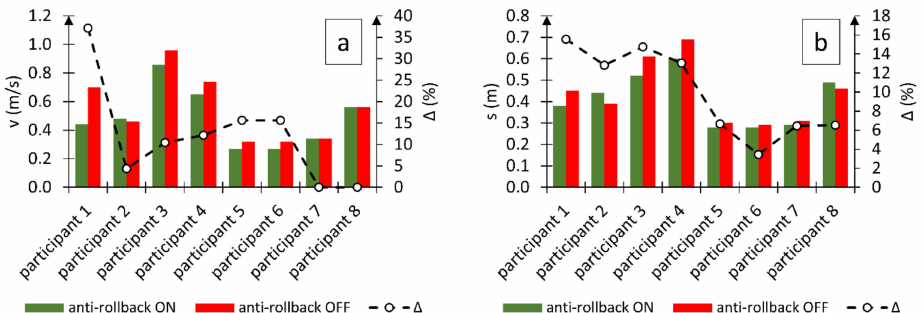
Figure 8. The diagrams of ( a ) the average values of the maximum velocity in the propelling cycle and a ( b )pathdistanceinasinglepropellingcycle(B)forrespectiveparticipantswiththeactivatedanti-rollback system (anti-rollback ON) and the deactivated anti-rollback system (anti-rollback system OFF). Where: ∆ —a percentage di ff erence between the parameter measured with the activated anti-rollback-system and with the deactivated anti-rollback-system.